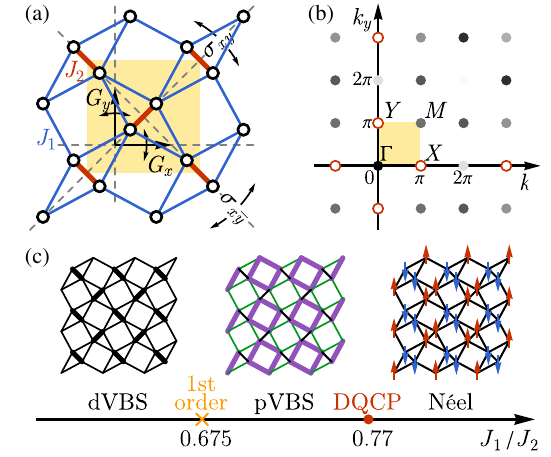
FIG. 1. (a) The Shastry-Sutherland lattice of copper sites (small circles) in SrCu 2 ð BO 3 Þ 2 , on which the spins reside. The spins are coupled across nearest-neighbor bonds ( J 1 , in blue) and dimer bonds ( J 2 , in red). Each unit cell contains four sites, as shaded in yellow. The glide-reflection ( G and G ) and the diagonal- x y reflection ( σ and σ ) symmetries are indicated on the lattice. xy x ¯ y (b) Diffraction peaks from copper sites. The darker dot indicates a higher intensity. The extinction points are marked out by red circles. The first Brillouin zone is shaded in yellow, correspond- ing to the unit cell in (a). Special momentum points Γ , X , Y , and M are defined as labeled. (c) The phase diagram of the spin model Eq. (1). The N´eel antiferromagnetic and DVBS phases are separated by the intermediate PVBS phase upon tuning the J 1 =J 2 ratio. The critical points are determined in Table I based on our IDMRG result. The transition between PVBS and N´eel phases is likely to be a DQCP (or weakly first-order proximate to a